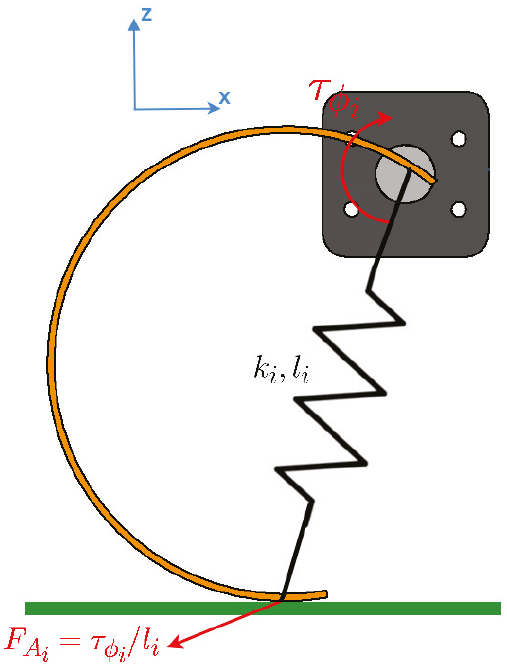
Figure 6. Leg forces on the XZ B plane.